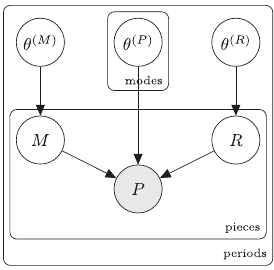
Fig. 3 Bayesian network depicting the generative process of a musical piece. Nodes and edges represent random variables and dependencies between them, respectively (Bishop, 2006, 2013; MacKay, 2003). For each time period, a piece is modeled as a pitch-class count vector P in R 12 , depending on the piece ’ s root R and mode M